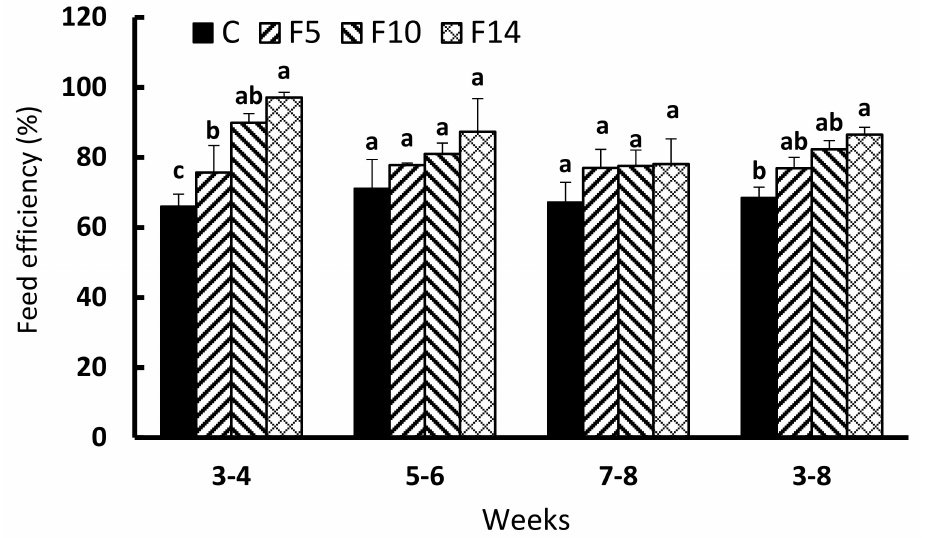
Figure 4. Changes in feed efficiency of juvenile leopard mandarin fish ( Siniperca scherzeri ) subjected to four feeding regimens across an 8-week trial: Control (C), fish fed continuously; F5, fish fasted for 5 days (days 10–14); F10, fish fasted for 10 days (days 5–14); and, F14, fish fasted for 14 days (days 1–14), prior to all fasted fish being fed to satiation. Values (mean ± standard error, n = 3) in the same column with dissimilar letters are significantly different ( p <